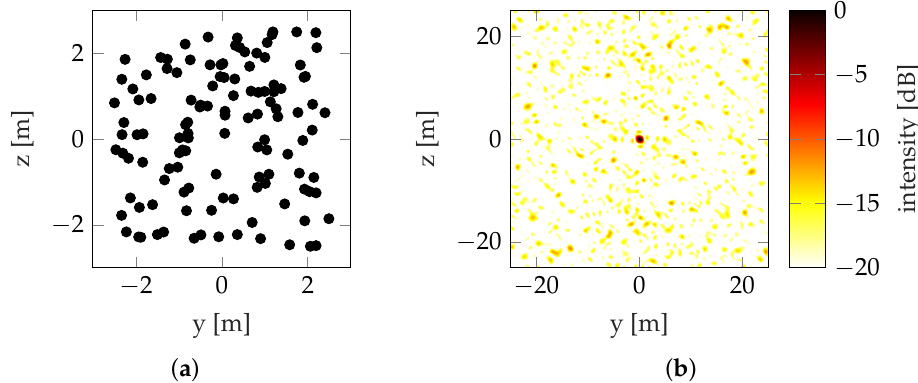
Figure 7. Randomly sampled aperture example: ( a ) Sampling points (“Trajectory”). ( b )